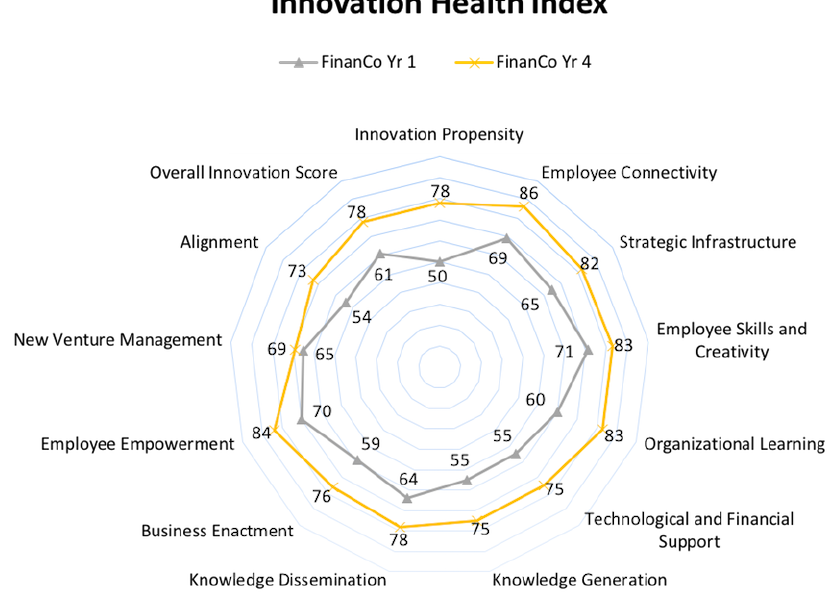
Fig. 6. FinanCo’s Year 1 vs. Year 4 Innovation Health Index Score